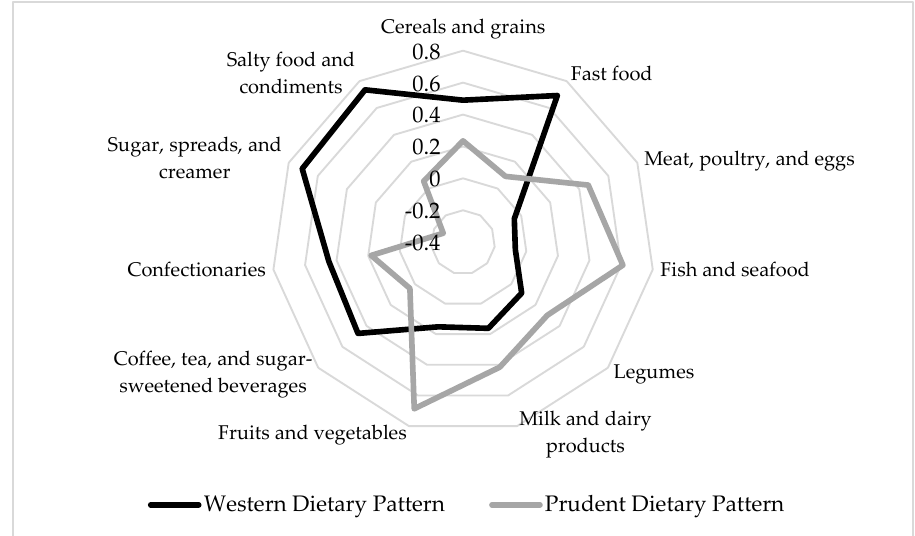
Figure 1. Diagram of factor loading scores of dietary patterns tested using principal component analysis. Only food groups with factor loading scores ≥ |0.3| are presented. The Western dietary pattern has high intakes of cereals and grains; fast food; coffee, tea, and sugar-sweetened beverages; confectionaries; sugar, spreads, and creamer; and salty food and condiments. The Prudent dietary pattern has high intakes of meat, poultry, and eggs; fish and seafood; milk and dairy products; and fruits and vegetables.